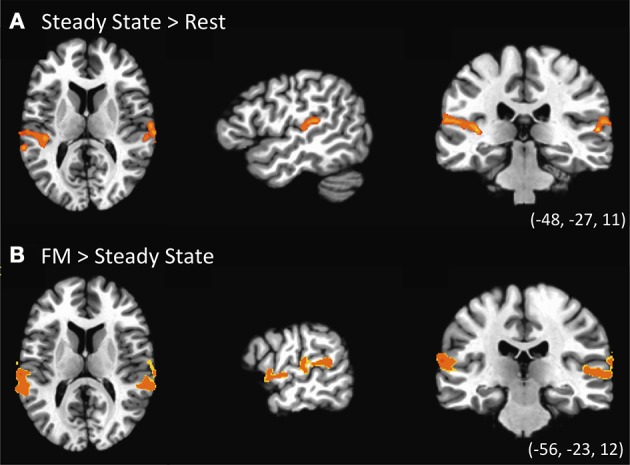
Univariate statistical contrasts. (A) Steady state condition vs. rest reveals bilateral activation in superior temporal gyrus within and around primary auditory cortex. (B) Frequency-modulated (FM) sweeps vs. steady state, showing greater activation for FM sounds in the superior temporal plane of both right and left hemispheres. Group statistical maps are superimposed on a standardized template. Voxel-wise threshold: p < 0.002, corrected to p < 0.05 for a 971 mm3 cluster extent.